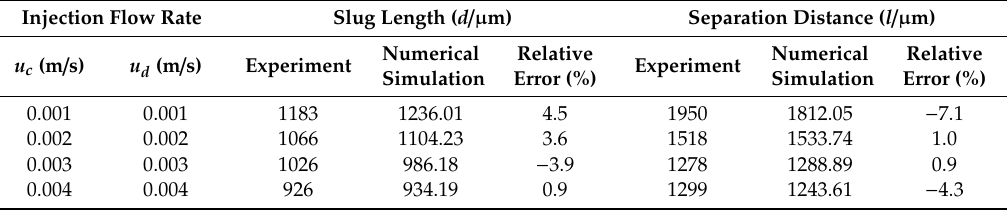
Table 4. Slug size comparison between experimental and simulated results.